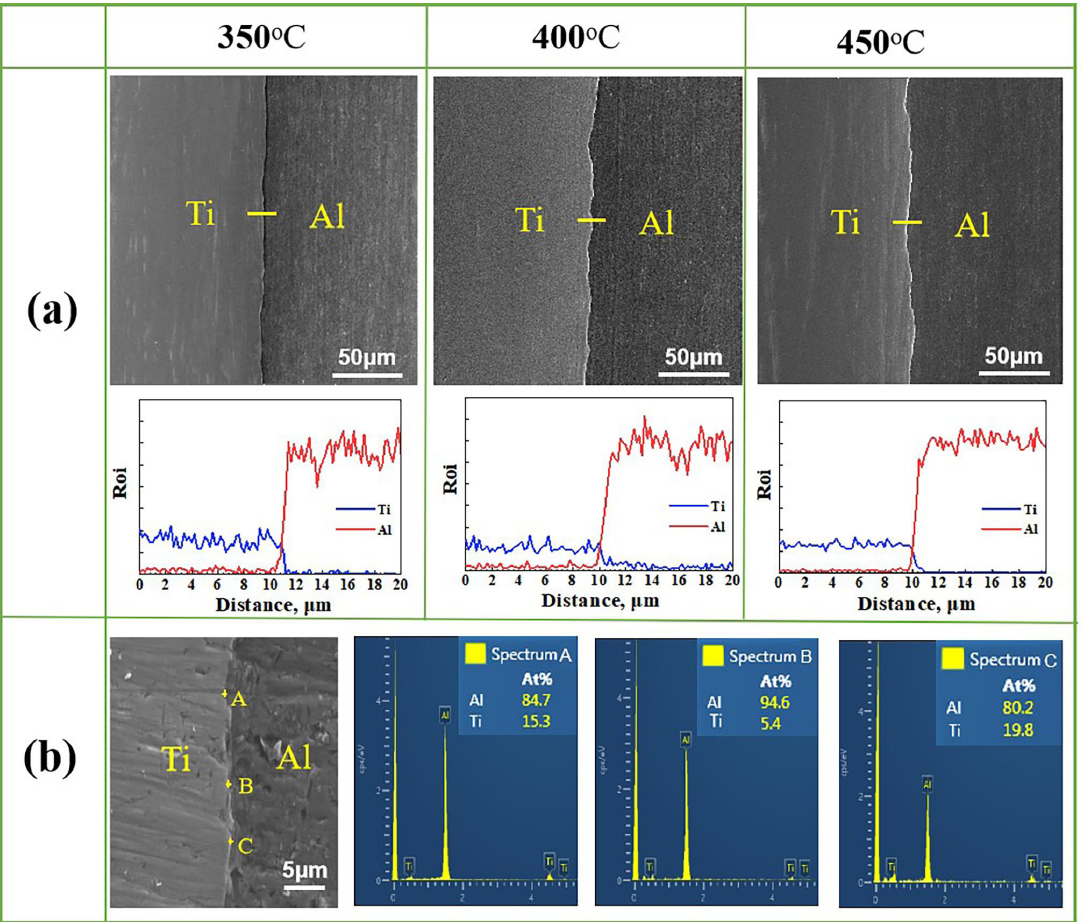
Figure 5. The SEM images of Ti/Al interface in LMCs: (a) the EDS line analysis at different temperatures, (b) the EDS point analysis at 450